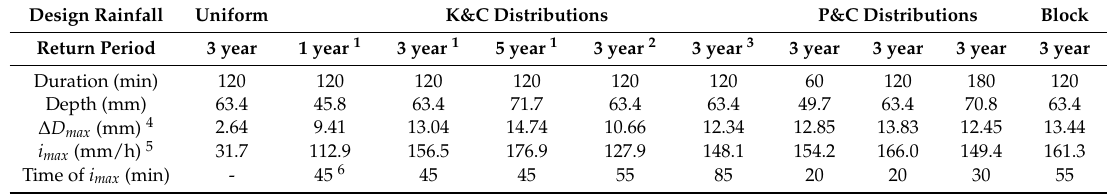
Table 2. Summary information for design rainfall distributions used in model simulations. Design